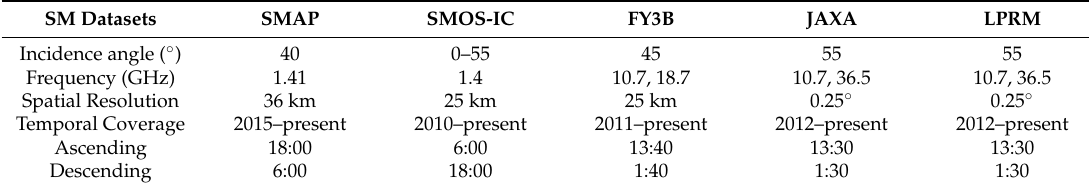
Table 2. Information of the five satellite-based soil moisture (SM)